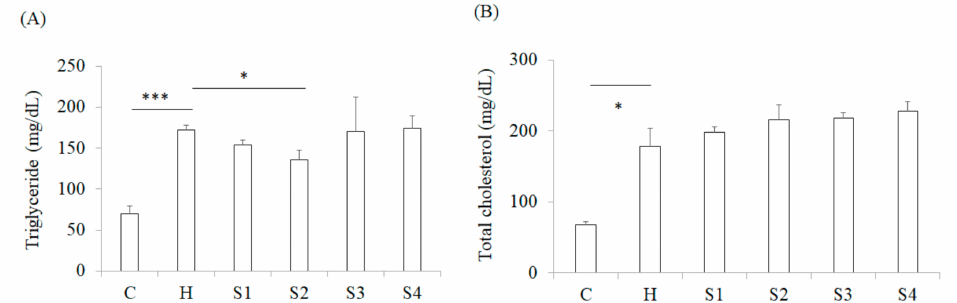
Figure 4. The effects of C. militaris on serum lipids of high-fat/sucrose diet-fed mice. Serum triglyceride ( A ) and total cholesterol ( B ) levels in mice after treating with samples for 8 weeks. Data are shown as means ± SEM ( n = 5). * p < 0.05, *** p < 0.001 compared to the H